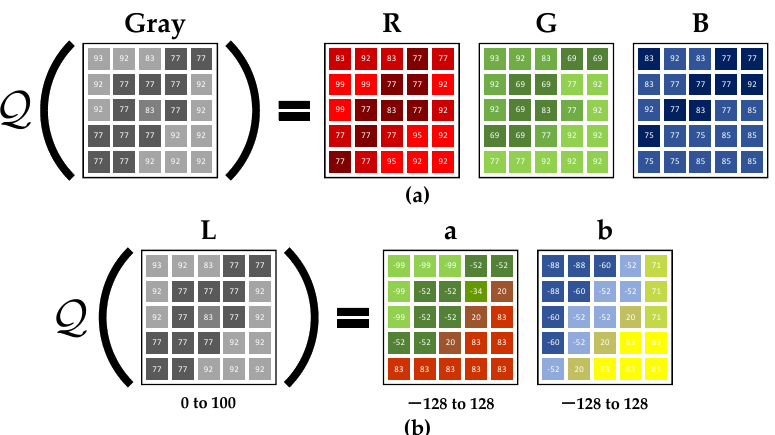
Figure 6. The principle of image colorization. ( a ) The direct mapping from the gray space to the RGB color space; ( b ) the hue Lab mapped from the gray space to the Lab color space.